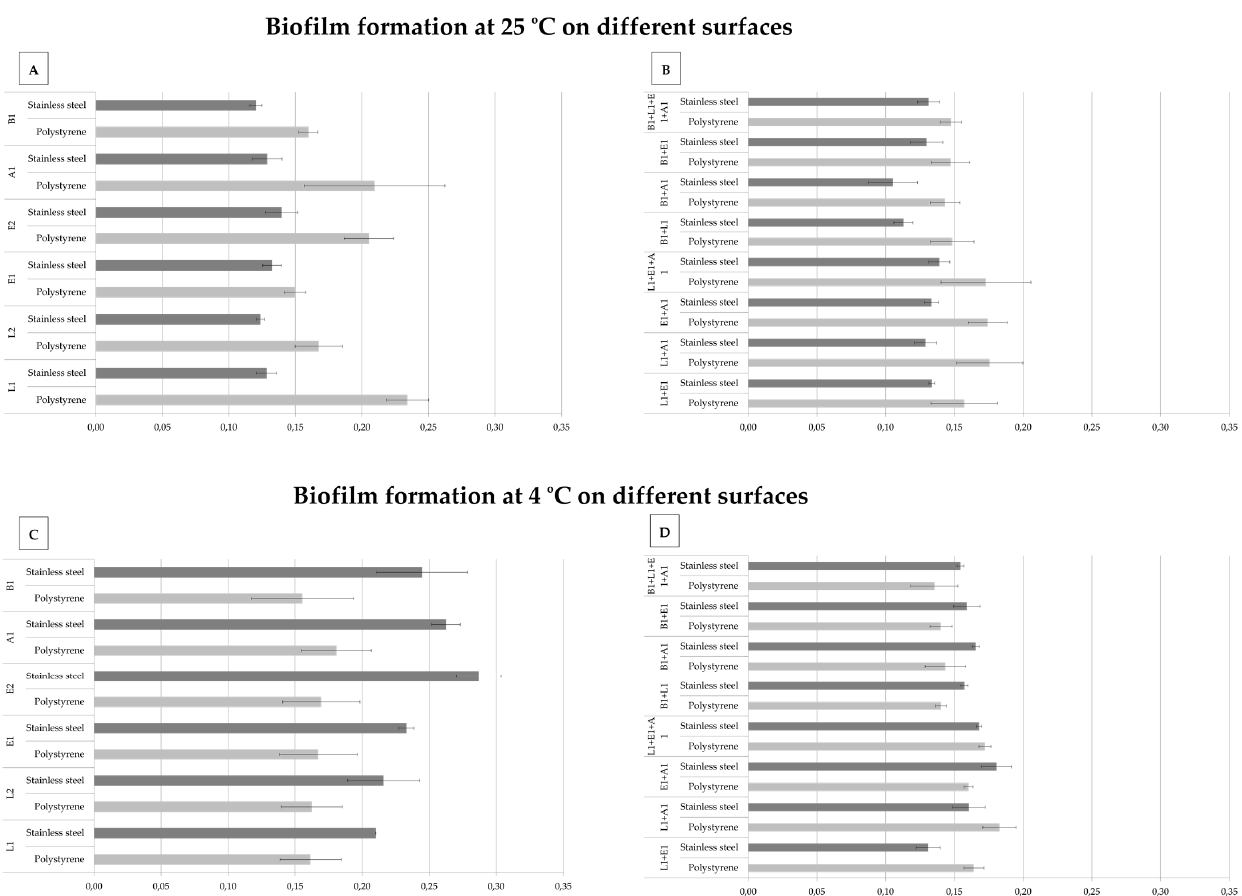
Figure 4. Biofilm formation by pure ( A , C ) and mixed ( B , D ) cultures under different temperatures, 4 °C for 12 days or 25 °C for 48 h, using two distinct contact surfaces (polystyrene and stainless steel). L1— L. monocytogenes CECT 937; L2— L. monocytogenes CECT 935; E1— E. faecalis QSE123; E2—